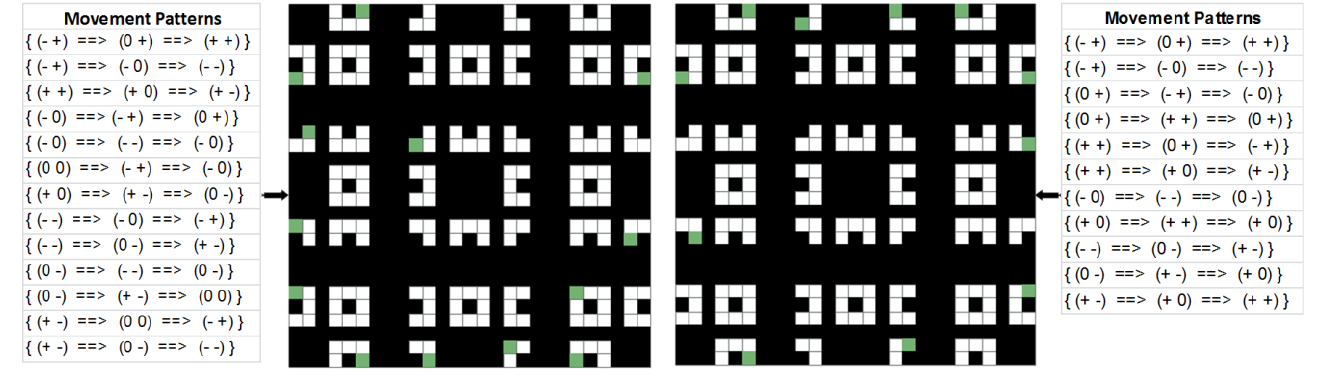
Figure 6. Movement patterns and SESIs for the trajectory pairs shown in Figure